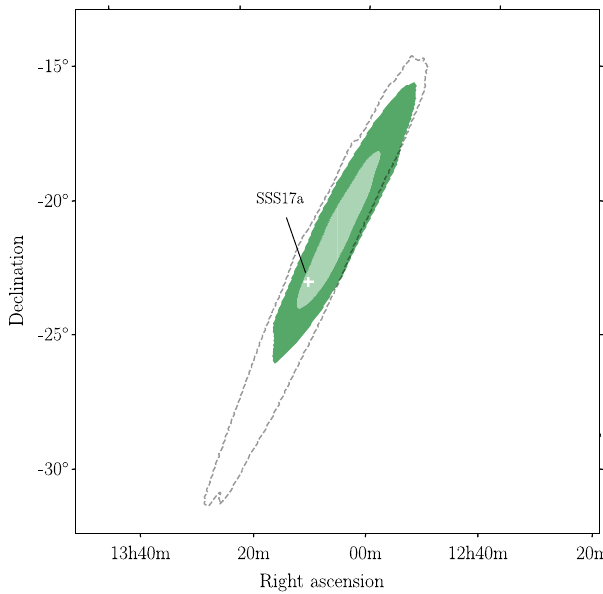
FIG. 3. The improved localization of GW170817, with the location of the associated counterpart SSS17a/AT 2017gfo. The darker and lighter green shaded regions correspond to 50% and 90% credible regions, respectively, and the gray dashed line encloses the previously derived 90% credible region presented in Ref.